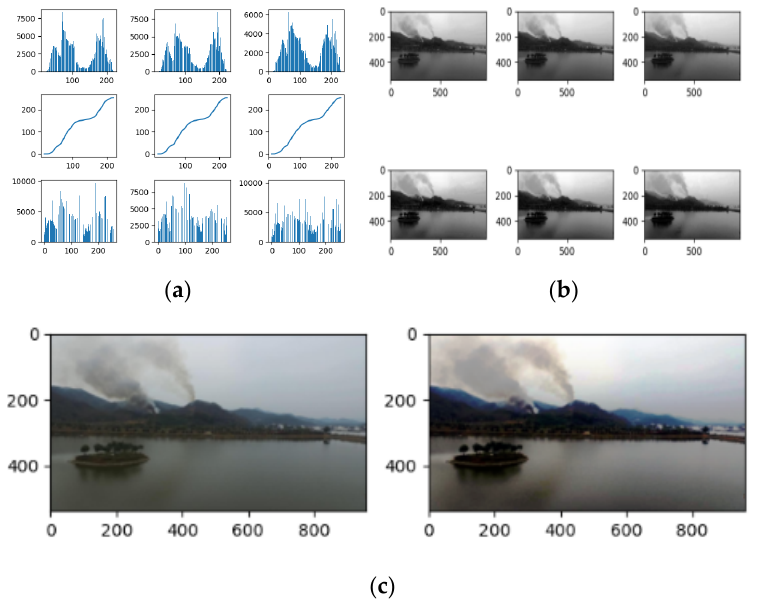
Figure 6. Histogram equalization: ( a ) original histogram of RGB channel, equalized histogram; ( b ) original image of RGB channel, equalized image; ( c ) original image, equalized